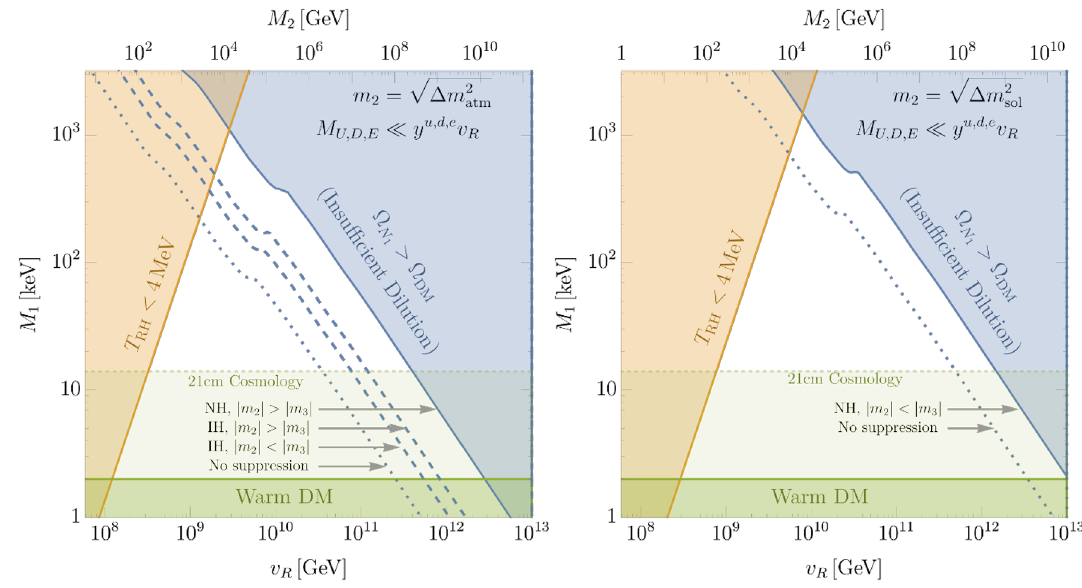
Figure 11 . The parameter space of N 1 DM produced by relativistic freeze-out and dilution from N 2 decay when the masses of the heavy fermions, M U,D,E , are far lighter than y u,d,e v R . The shaded regions are identical to figure 2, except that the beta decay rate of N 2 is suppressed, shifting the ( blue ) insufficient dilution region to higher v R . The N 2 beta decay rate decreases as the two heaviest generations of ¯ q and ¯ ‘ becoming heavy, reducing the kinematically allowed decay channels and inducing suppressions from the PMNS matrix. We show the allowed regions for m 2 = √ ( left ) and m 2 = ∆ m 2 ( right ). The blue contours show how the insufficient dilution boundary sol depends on whether ν 2 and ν 3 obey a normal (NH) or inverted hierarchy (IH). Bounds from hot DM are discussed in the